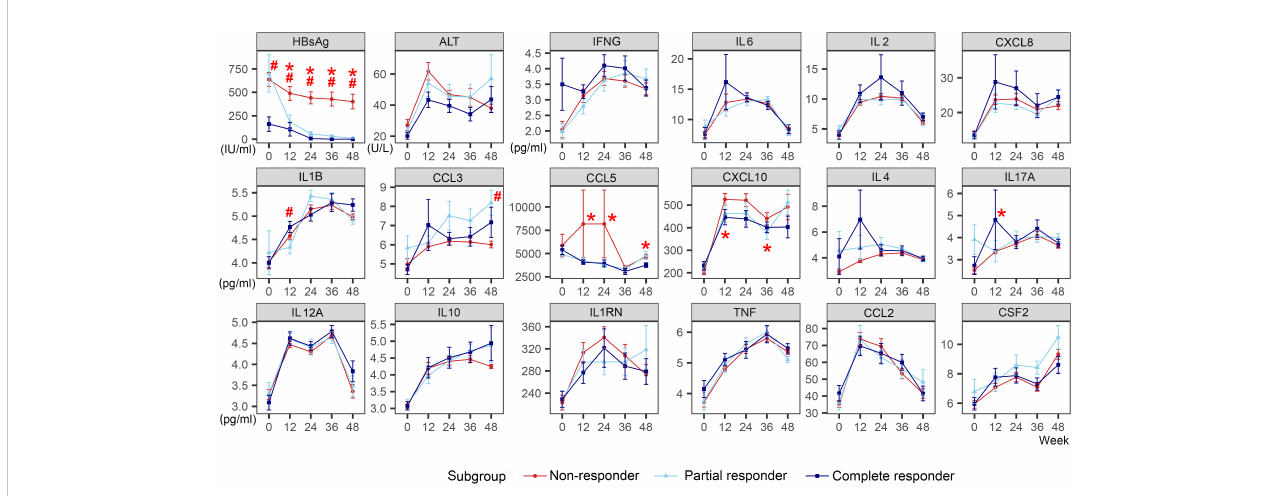
FIGURE 2 Dynamic changes of HBsAg, ALT, and cytokines of different response subgroups in the Add-on group. The line represents the mean and the bar represents the standard error. #, signi fi cant differences in cytokine levels among the three subgroups, P <0.05; *signi fi cant differences in the amplitude of cytokine change from baseline among the three subgroups, P <0.05. HBsAg, hepatitis B surface antigen; ALT, alanine aminotransferase; Add-on, nucleos (t)ide analogs combined with pegylated interferon alpha therapy; complete responder, achieving HBsAg loss at week 48; partial responders: achieving HBsAg decreased by > 1 log from baseline but HBsAg remains positive at week 48; non-responder, achieving HBsAg decreased by < 1 log from baseline and HBsAg remain positive at week 48.